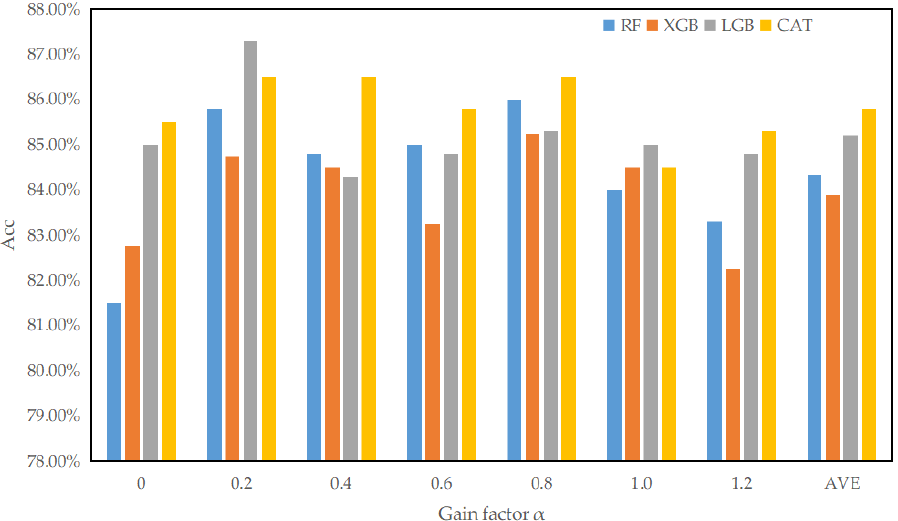
Figure 6. A comparison histogram of classification accuracy based on different ensemble-learning algorithms with variable gain factors. α is the gain factor. The XGB, LGB, and CAT in the figure denote algorithms based on XGBoost, LightGBM, and CatBoost, respectively.